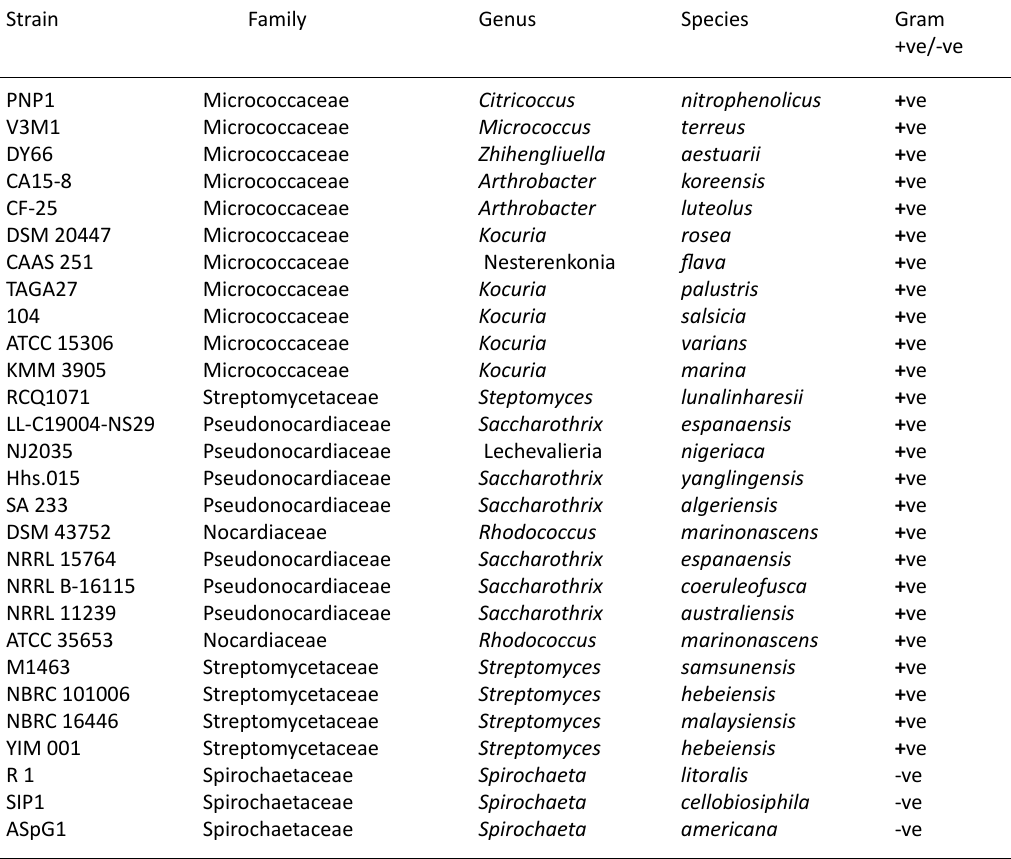
Table 1. Bacterial populations identified in Perna perna